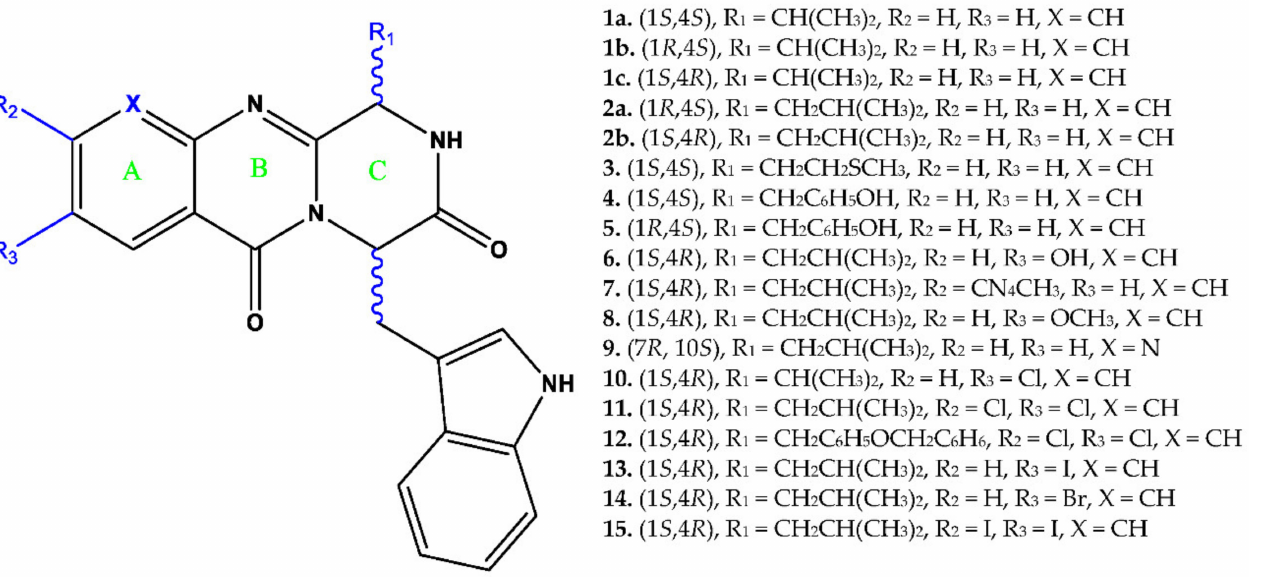
Figure 1. Chemical structure of the fiscalin derivatives under research in the present